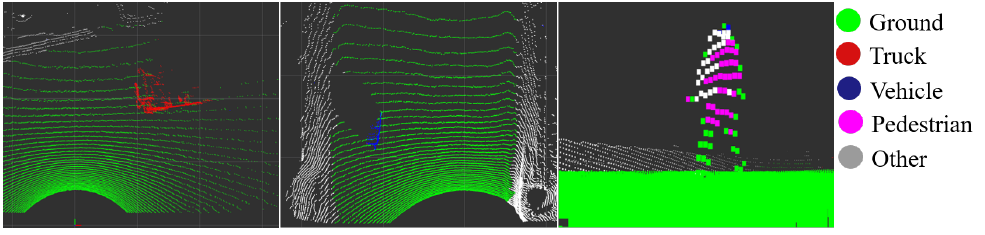
Figure 3. Illustration of cloud-semantic